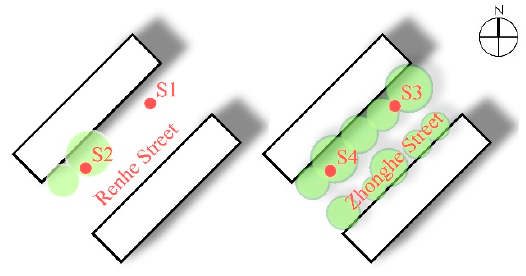
Figure 4. Monitoring sites of streets with different green coverage ratios.